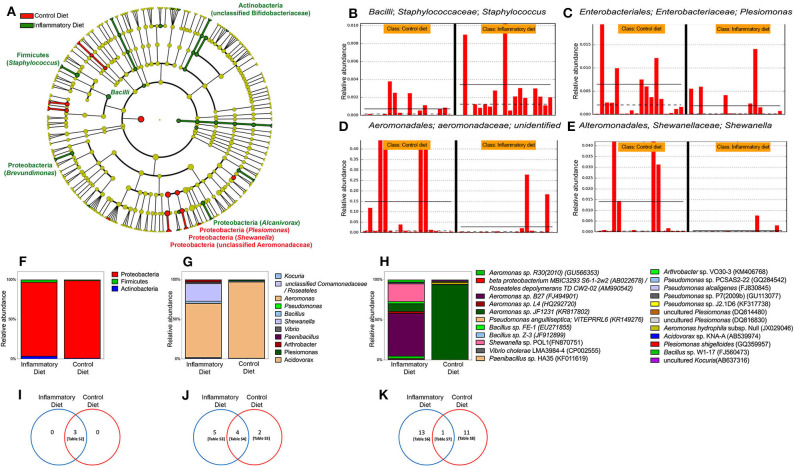
Gut microbiota changes induced by soybean meal diet. (A) Cladogram showing significant changes in genus relative abundance in 9 dpf zebrafish larvae labeled [phylum, (genera)] unless otherwise noted. Circle color indicates change in abundance: yellow, no change; red, elevated in fishmeal (FM); and green, elevated in soybean meal (SBM). Linear discriminant analysis (LDA) effect size analysis (LEfSe) score >3 was considered significant. QIIME data analysis was used. (B–E) The four most significant taxa. The horizontal solid straight line in each panel indicates the group means, and the dotted line indicates the group medians. (F–H) Analysis of cultivable microbiota, relative abundance of phyla. (I–K) Venn diagrams showing exclusive or shared phyla, genera and species respectively. Tables S2–S8 are detailed in Supplementary Material.